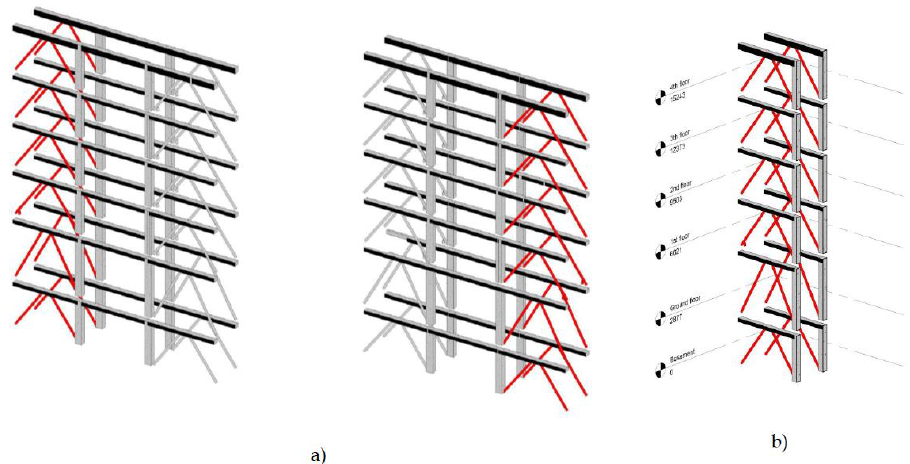
Figure 21. Additional steel bracings: ( a ) both Sections A and C; ( b ) detail on Section A.